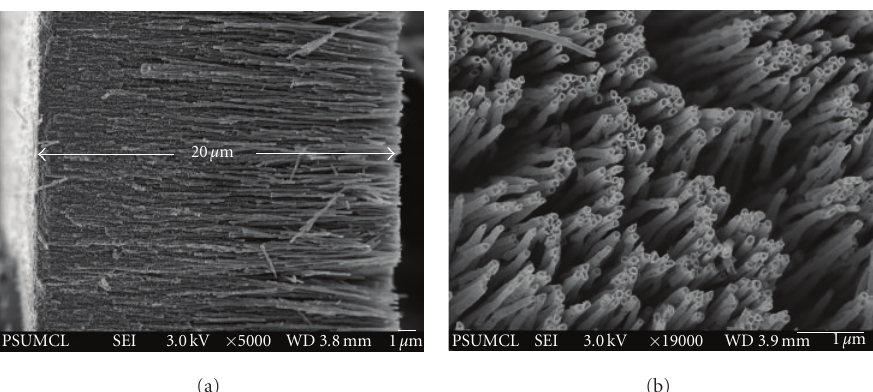
Figure 1: (a) FESEM image of a 20 μ m long TiO 2 nanotube array (pore size 95nm and wall thickness ∼ 10 nm) on FTO-coated glass and (b) top view of the nanotubes. Reprinted with permission from [35].